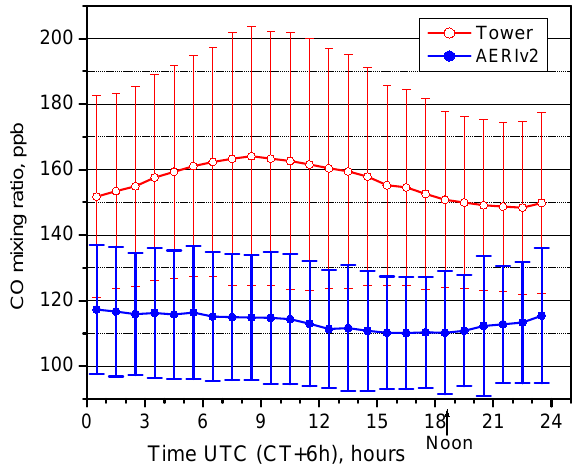
Fig. 10. Example measurement results for clear sky conditions of 8 June 2007. A difference between measured and calculated radi- ances RD (blue dots) anticorrelates with the AERI CO v1 around lo- cal noon (slope= − 198, R 2 =0.92). Although the amplitude around noon for AERI CO v2 is less, it appears the correction for scattered sunlight is not complete.